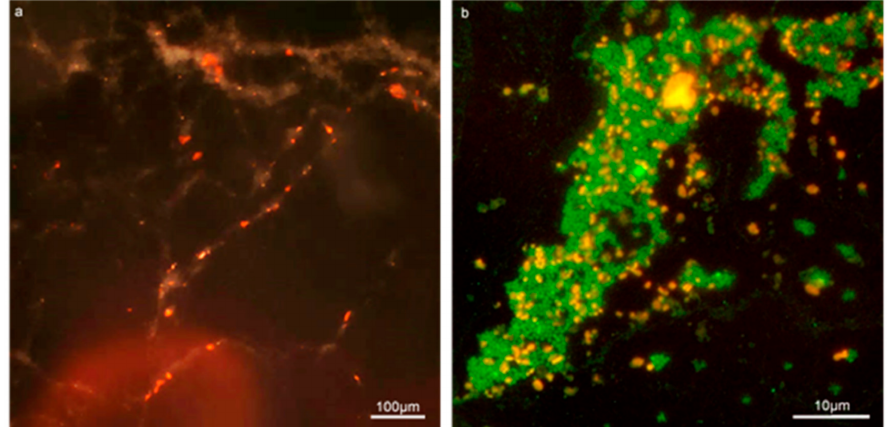
Figure 2. Con-A and SYTO9 effectively stains the EPS and cellular content of enterococcal biofilm in the Gene Frame biofilm apparatus (GFA). ( a ) 10 × composite micrograph of 24-h biofilm produced by MF04010 using a dark field and the G2-A filter to capture the red fluorescence staining of Con-A bound to the EPS. ( b ) 100 × fluorescent micrograph of MF06036 24-h biofilm stained for cellular content with SYTO9 (green) and EPS with Con-A (red).